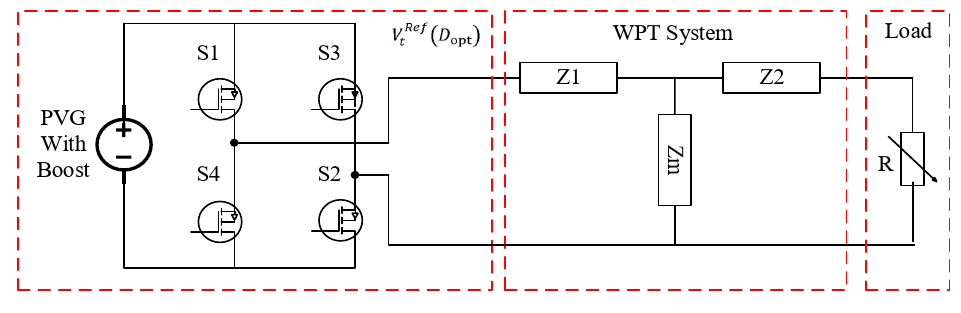
12 of 23 Figure 12. Practical coefficient of coupling. 3.2. Derivation of Adaptive Reference Values To derive the proposed AVIC, derivation of adaptive references is required. The circuit diagram of an H-bridge inverter supplying a WPTS is given in Figure 13. In this figure, Z 1 is the impedance of the transmitting side circuit and Z 2 is the impedance of the receiving side circuit. 𝑍 (cid:3040) is the mutual impedance between the transmitting and the receiving side circuits. From Equation (10), the mutual inductance is proportional to 𝑘(𝑑) , which is a function of the distance according to Equation (11). The value of the mutual impedance is proportional to the coupling coefficient which is the